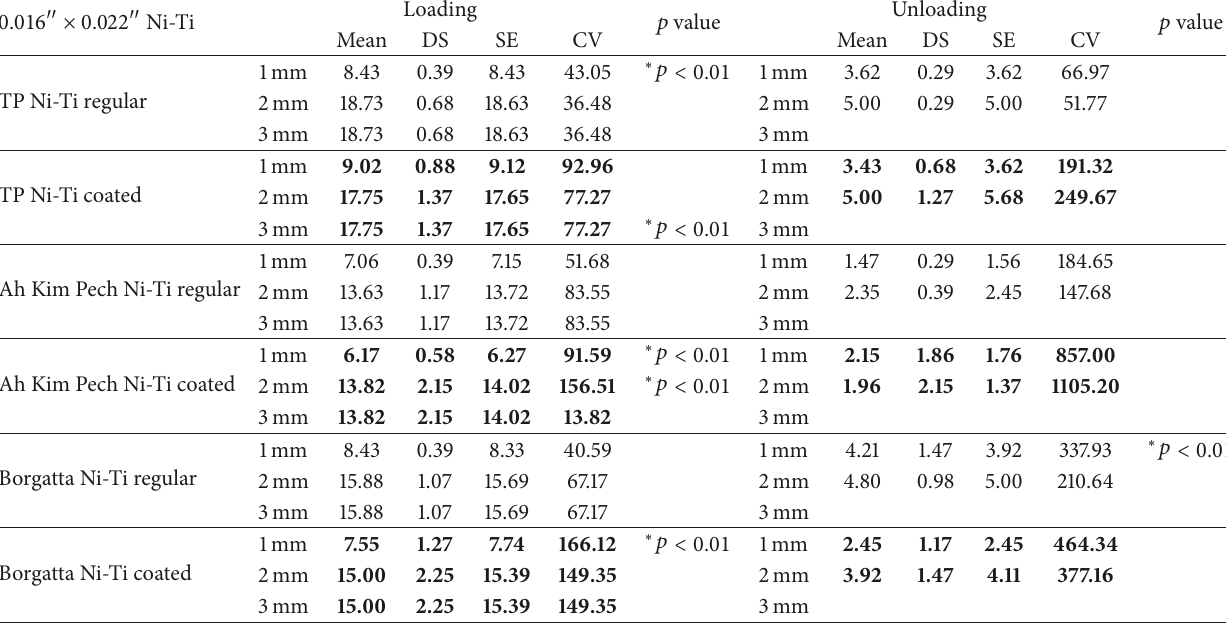
Table3:ComparisonofmeanforceinNewtonsbetweentheregularandcoatedNi-Tirectangular 0.016 󸀠󸀠 × 0.022 󸀠󸀠 wiresatdifferentdeflection loads. The results are expressed as the mean ± SEM for 15 Ni-Ti wires. ∗ 𝑝 < 0.01 , experimental group significantly less than